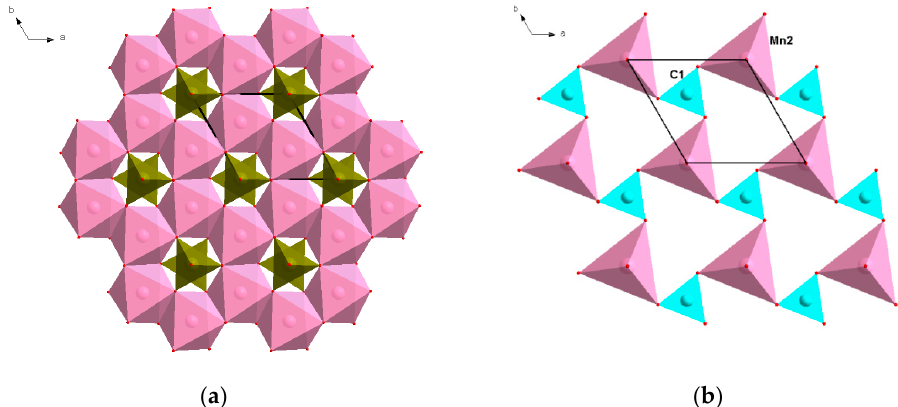
Figure 5. Gibbsite-like ( a ) and kalsilite-like ( b ) layers in the ab projection of the K 2 Mn 3 [VO 4 ] 2 (CO 3 ) crystal structure. Table 1. Mero-plesiotype series of vanadates, arsenates, and phosphates of the first-row transition metals.